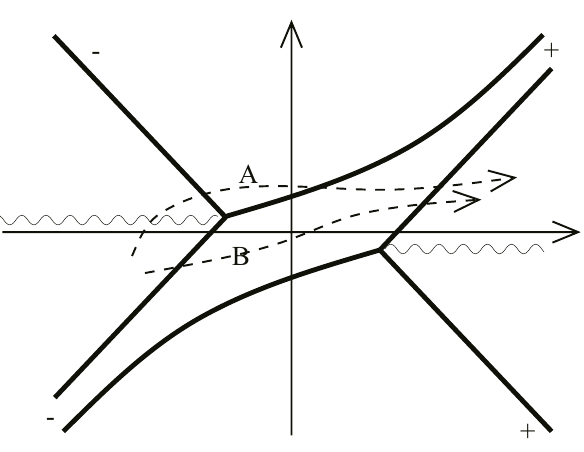
Figure 6 . The Stokes lines for the inverted quadratic potential with E < 0 . The wavy lines are the